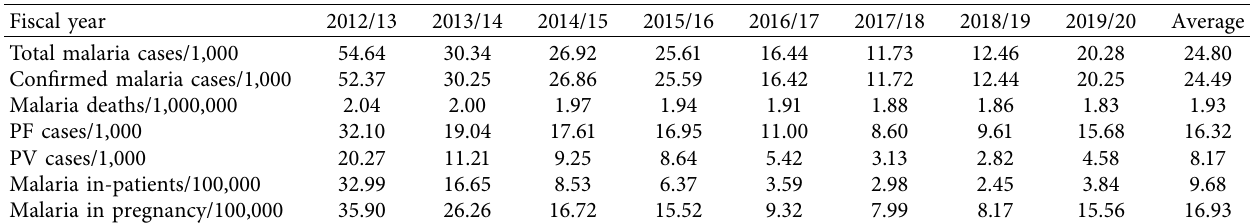
Figure 2: Total malaria cases by year, age group, months, plasmodium species, seasonal variation, and annual trends in the Amhara region, Ethiopia, between July 2012 and June 2020. (a) Monthly malaria cases and trends. (b) Total malaria cases by age groups. (c) Total confirmed cases by plasmodium species. (d) Monthly variations in the annual trends of malaria cases. Table 1: Annual malaria incidence for selected malaria indicators, Amhara region,